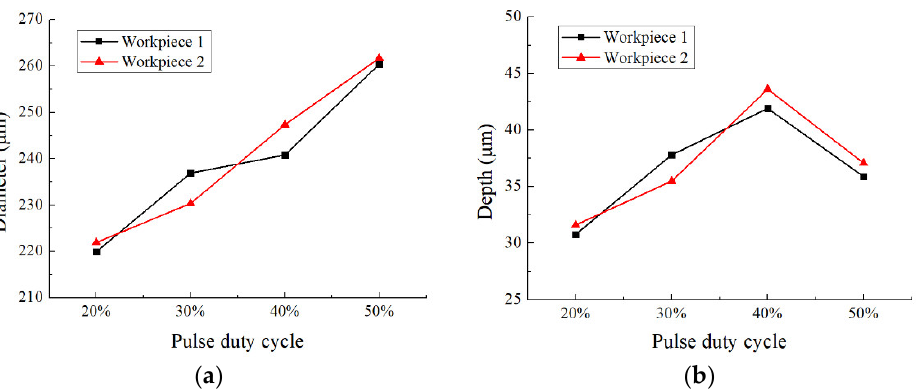
Figure 13. The effect of pulse duty cycle on the dimension of micro dimples. ( a ) Diameter; ( b ) Depth.